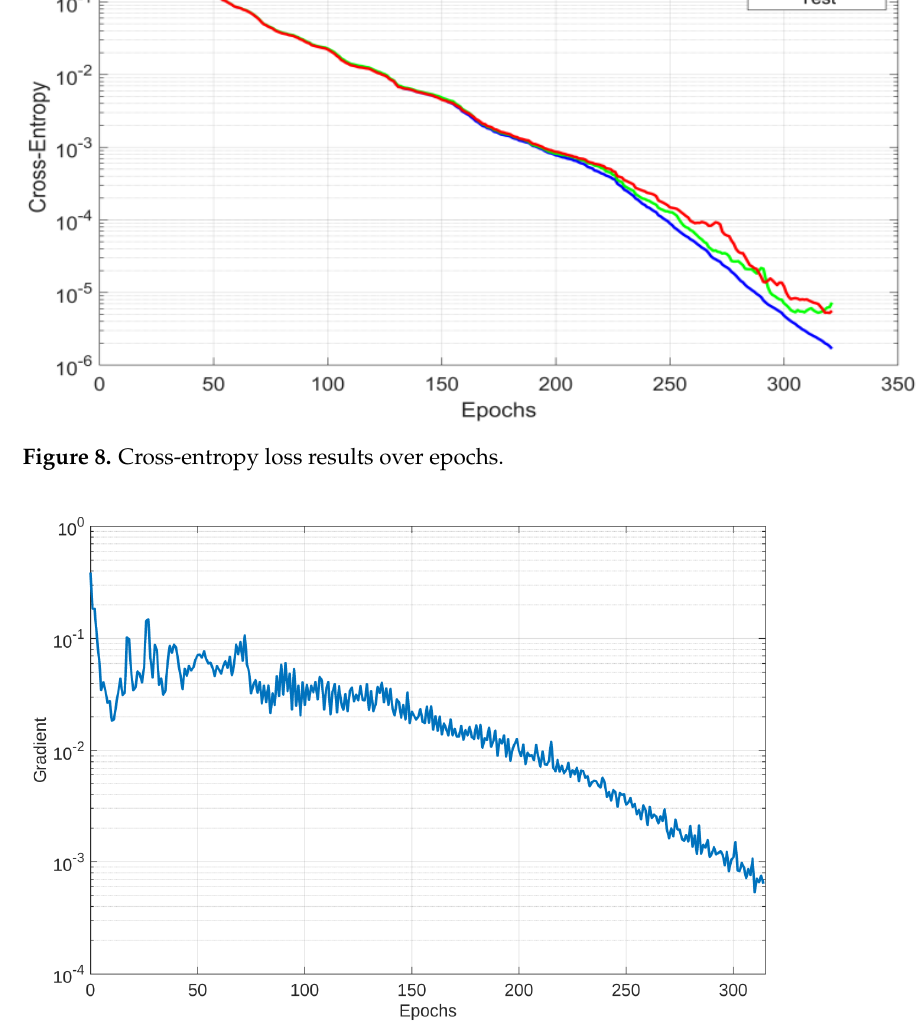
Figure 9. Gradient variation over epochs.